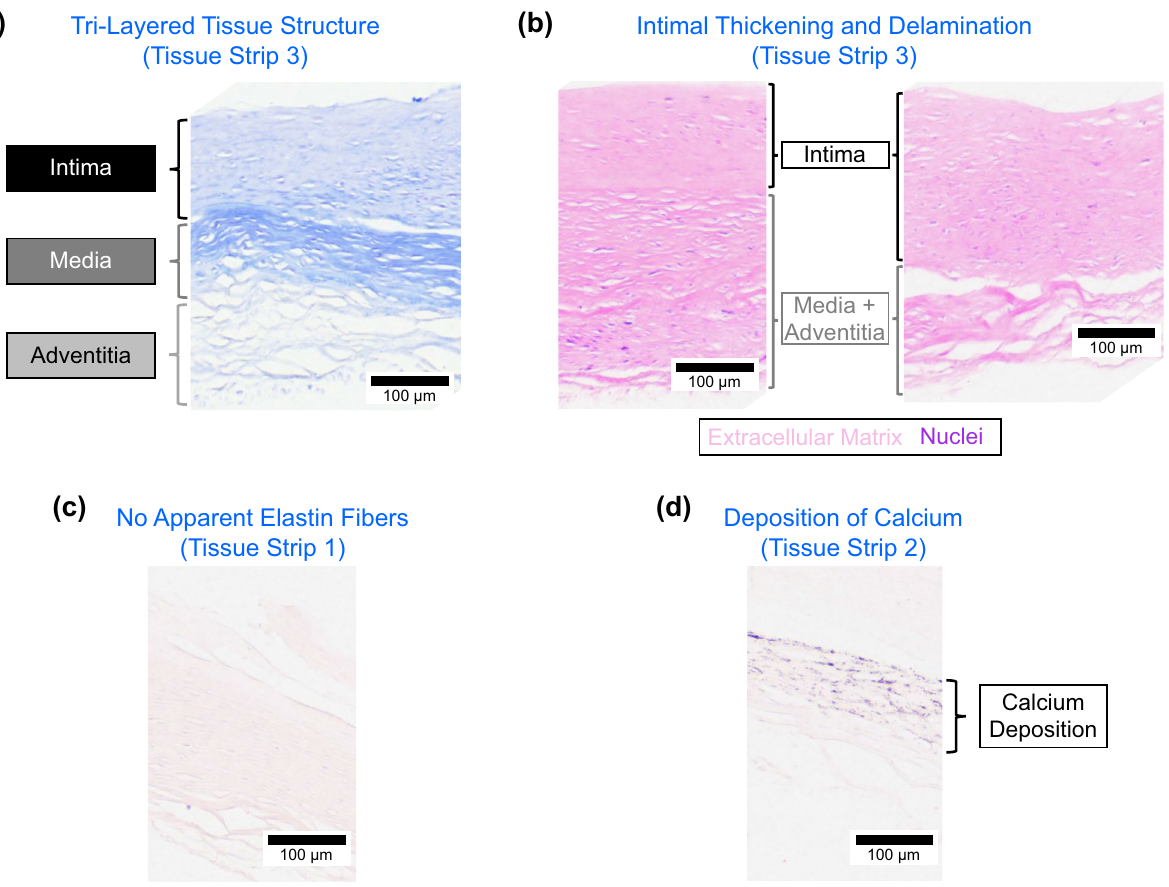
Figure 5. Micrographs of the histology slides showing: ( a ) the three arterial layers (Masson’s trichrome) according to definition in Robertson et al. 20 , ( b ) the thickening of the intimal layer and heterogeneity of the cells (Hematoxylin and Eosin), ( c ) lack of the elastin (Verhoeff van-Gieson), and ( d ) calcium deposition (von